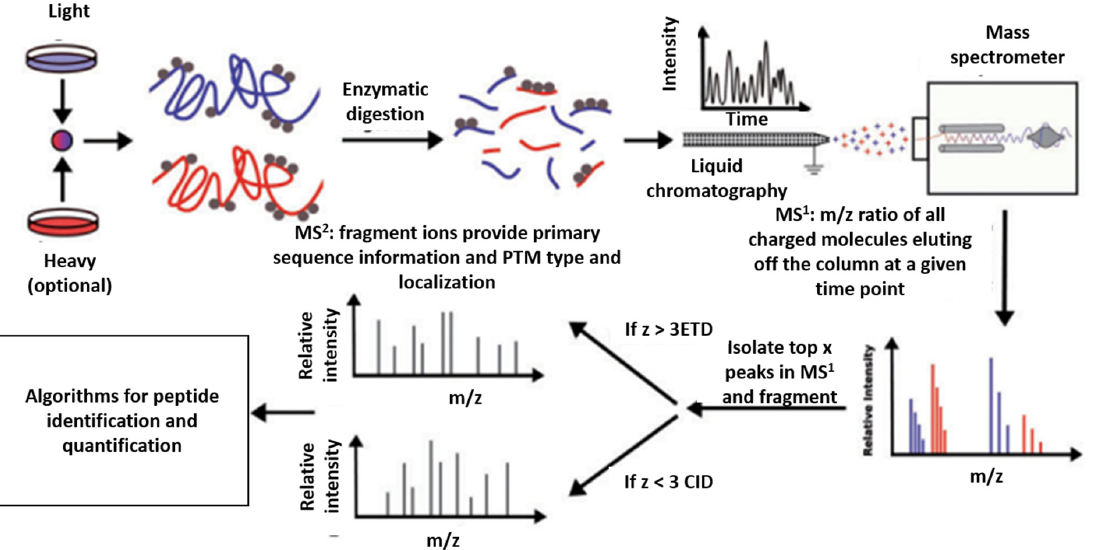
Figure 3. MS-based proteomics. Illustration of the steps involved in MS proteomics analysis [30]